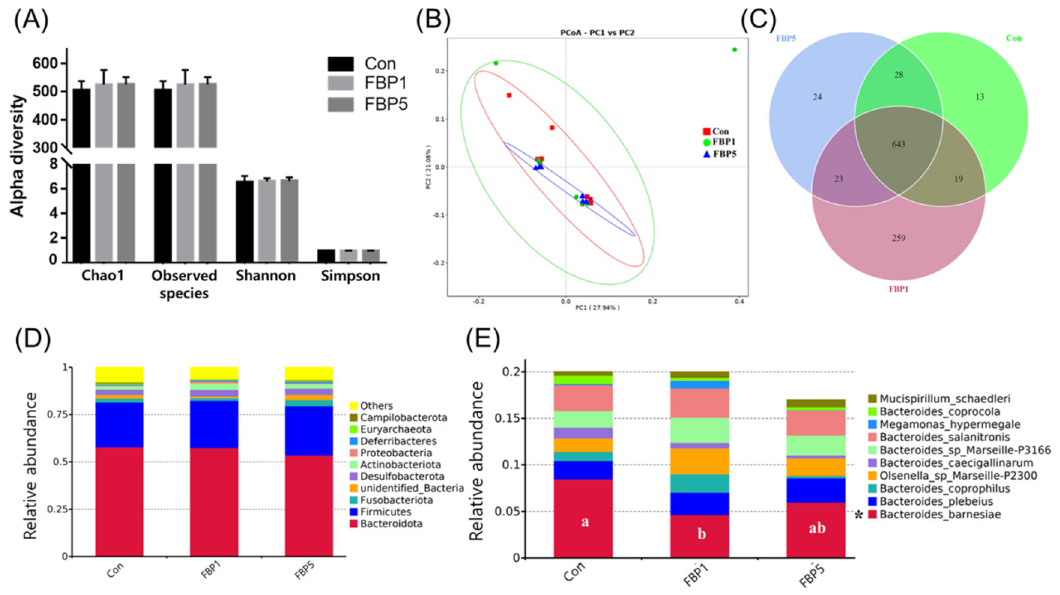
Figure 7. Dietary effects of the Lp − fermented B. papyrifera product (FBP) under practical condition on gut microbiota of laying hens. ( A ) Alpha diversity, ( B ) PcoA plot, ( C ) Venn diagram, ( D ) dominant phylum, ( E ) top 10 dominant species. Con: the hens fed with basal diet; FBP1, the hens fed with 1% (wt/wt) FBP product in basal diet; FBP5, the hens fed with 5% (wt/wt) FBP product in basal diet. * and letters indicate significant difference among the treatments at p < 0.05 level.